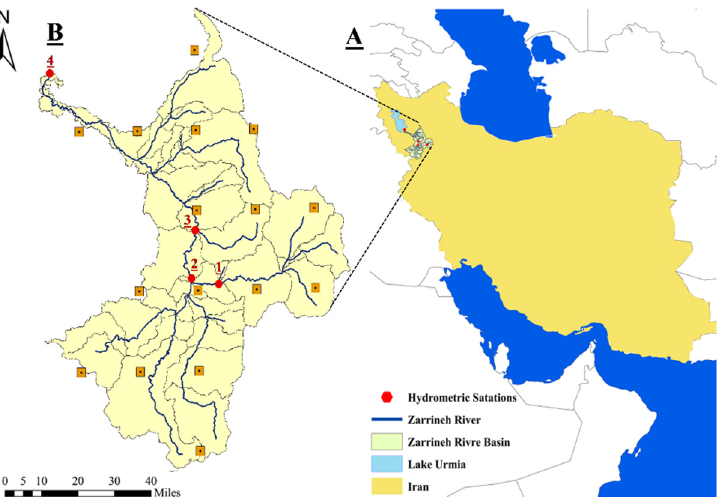
Figure 1. Zarrineh River basin: Part ( A ) shows the location map of the Zarrineh River basin in the northwest of Iran and part ( B ) shows the Zarrineh River basin and its rivers network along with hydrometric and meteorological stations 1–4.